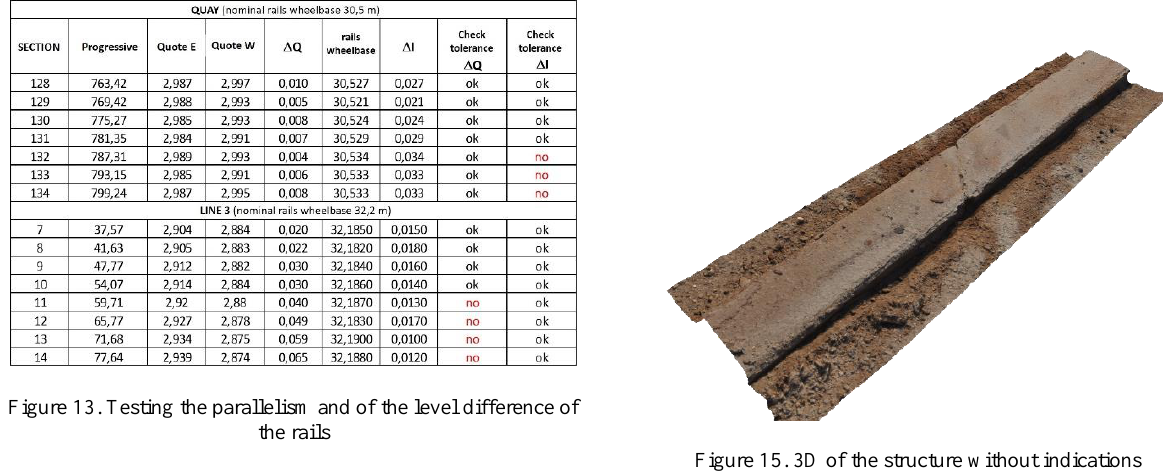
Figure 15. 3D of the structure without